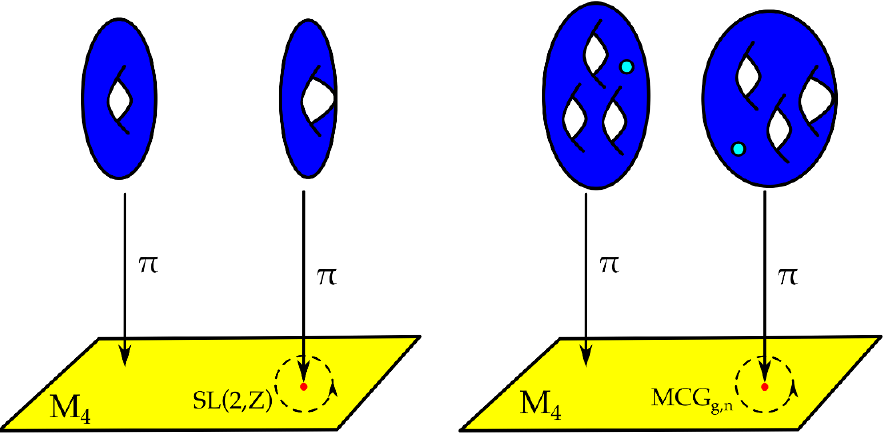
Figure 1 . Theories of Class F: a sketch of the structure of the 6d space-time for the (2 ; 0) theory, which upon reduction along the (cid:12)bration (cid:25) gives rise to theories of class F, for T 2 and C 3 ; 1 , respectively, which are 4d theories on M 4 with varying coupling. Singularities in the (cid:12)ber result in monodromies of the couplings of the 4d theory, which take values in the mapping class group MCG g;n . On the left hand side this is SL(2 ; Z ). In the class F theories the singular loci correspond to duality defects (shown in red), which are real codimension two in M 4